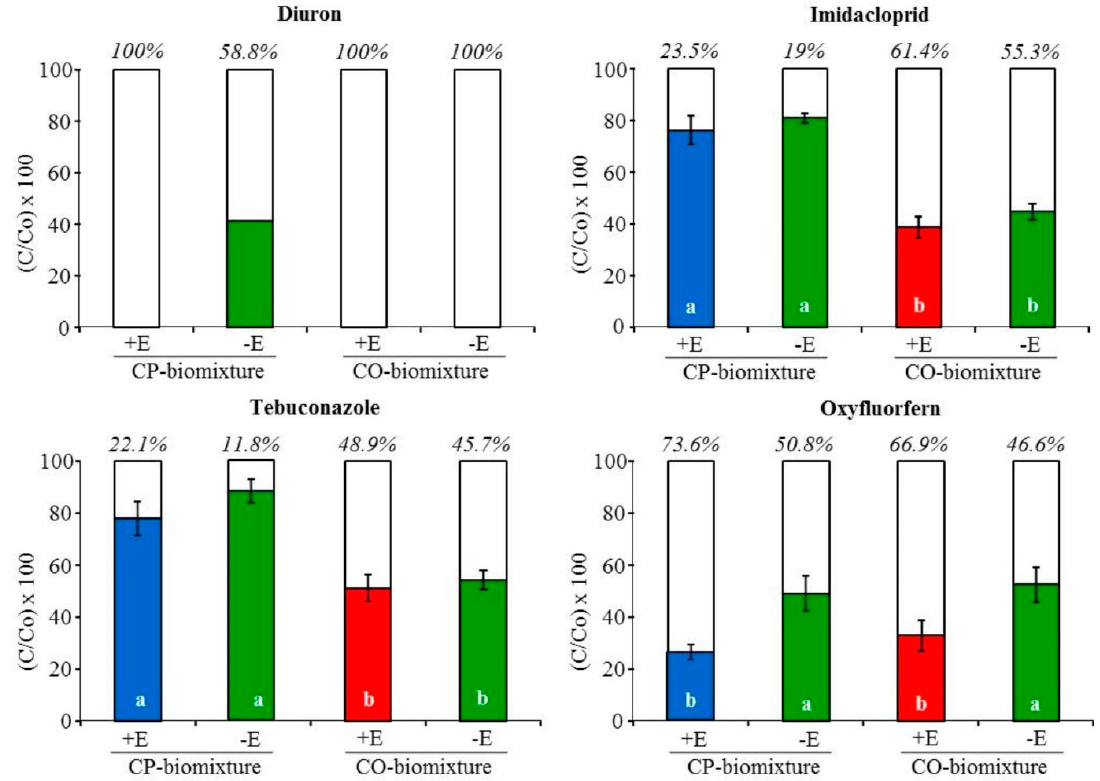
Figure 4. Relative concentration (C / C O × 100) of residues (colored bars) and dissipated percentage (white bars) of diuron, imidacloprid, tebuconazole and oxyfluorfen in the CP and CO biomixtures, treated ( + E) or not ( − E) with E. fetida after 12 weeks of vermicomposting. Error bars represent the mean standard error. For each pesticide residue, means followed by the same letter do not significantly differ ( p < 0.05).